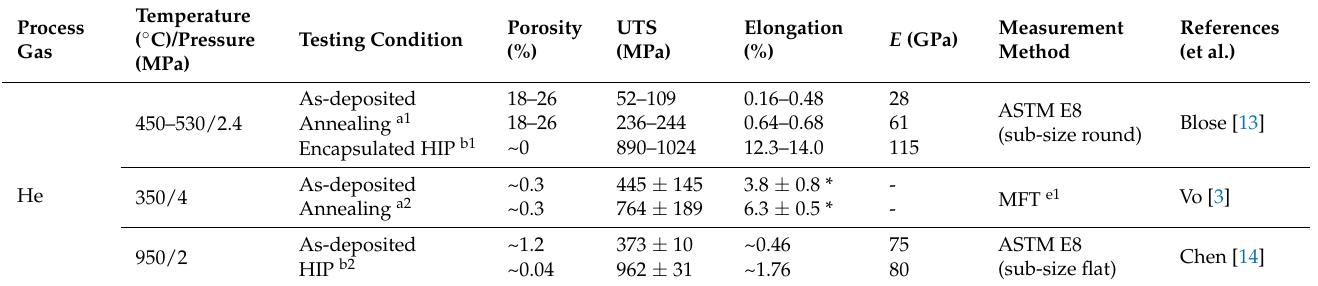
Table 2. Tensile properties of fully cold spray deposited Ti6Al4V reported in the literature, and data generated from this